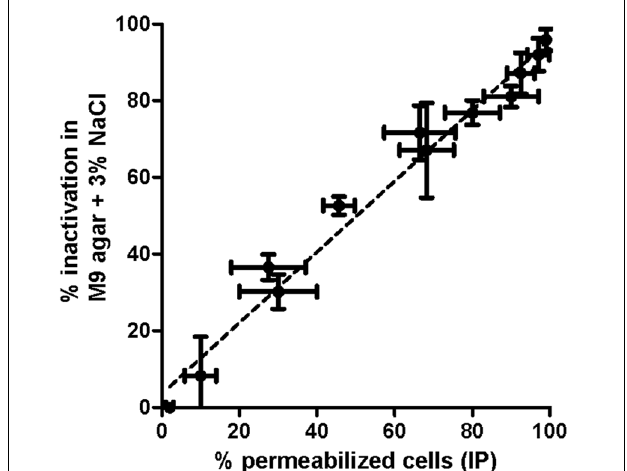
FIGURE 6 | Correlation and linear regressions between percentage of permeabilization of E. coli BW25113 cells after PI staining (measured in fluorescence microscope) and the proportion of inactivated cells (measured by plate count in M9 agar containing 3% NaCl). Thermal treatments at 55 ◦ C of different durations (0–3 min) were applied in M9 broth to obtain a variety of samples. Error bars represent standard deviation of the mean from three